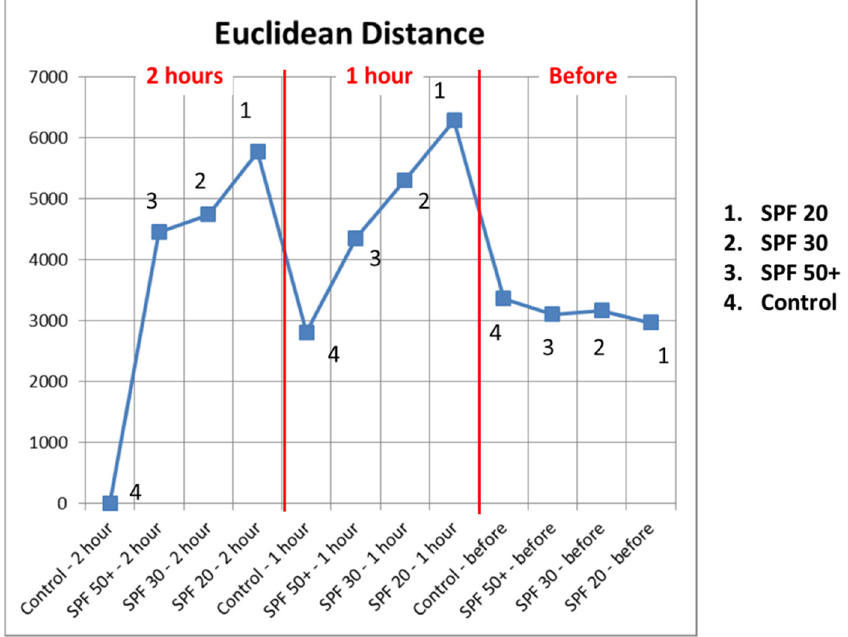
Figure 8. The Euclidean distances of skin control site after 2 h to different skin sites before and after the sun tan lotion application, where skin site 1: SPF 20, 2: SPF 30, 3: SPF 50+, and 4: control.